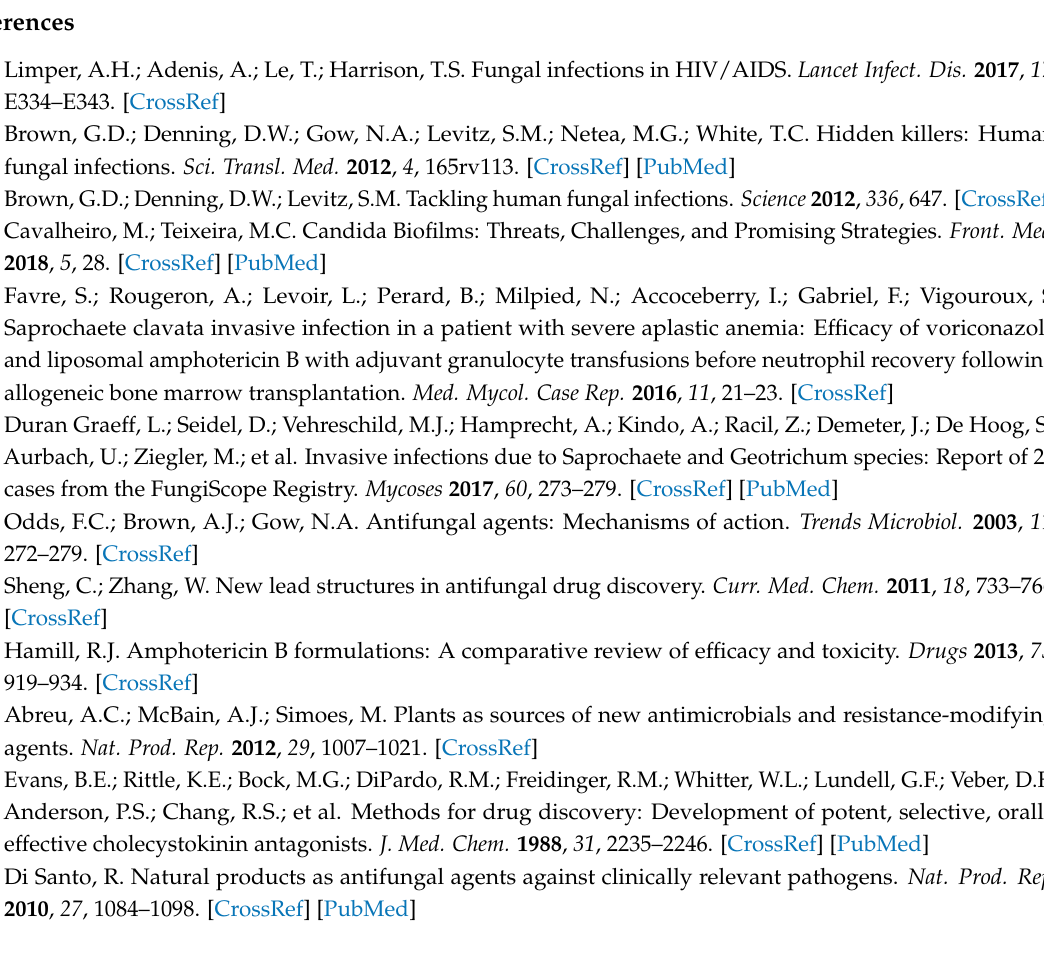
Supplementary Materials: The following are available online. Table S1. Nonlinear regression parameters of Figure S1. Dose-response curves of chalcone 28 obtained with non- Candida yeasts; Table S2. Nonlinear regression parameters of the dose-response curves of chalcone 28 against non Candida spp. clinical